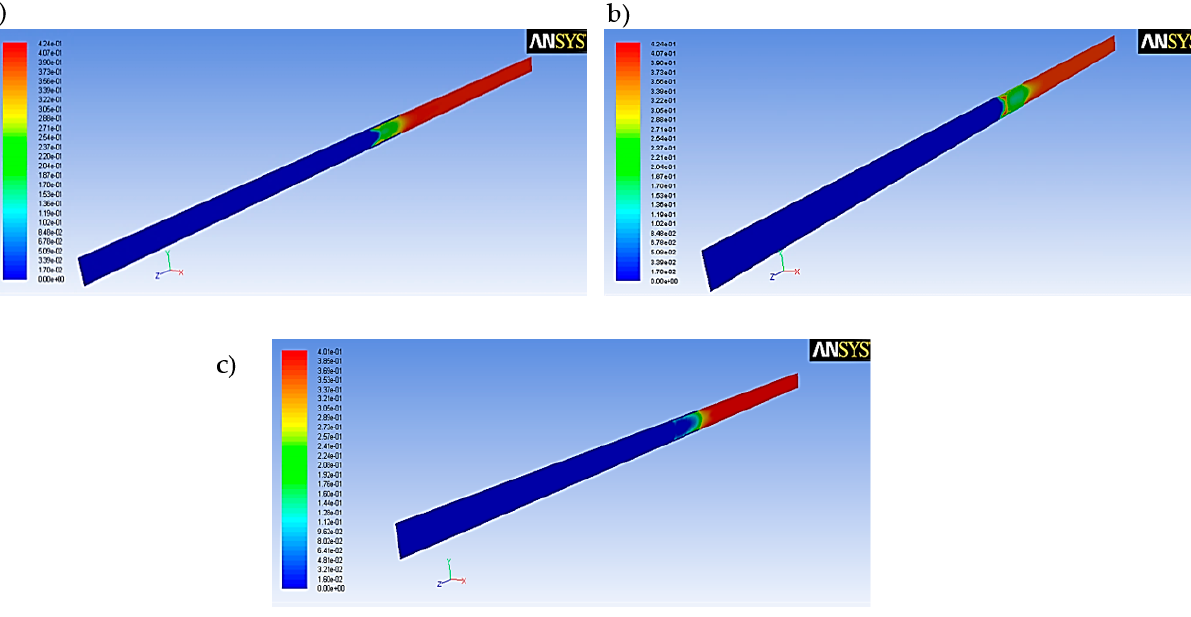
Figure 23. Changes of the syngas components determined empirically and from numerical calculations: ( a ) for the coal sample from hard coal mine A, ( b ) for the coal sample from hard coal mine B, ( c ) for the coal sample from hard coal mine C. Figures 24–27 shows the map of syngas composition including CO, CO 2 , CH 4 and H 2 of the numerical simulation of the base case using the CFD method.